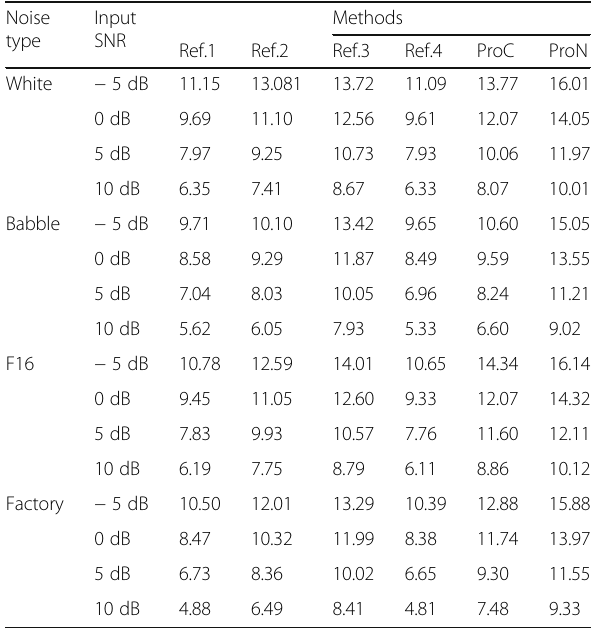
Table 2 Test results of SSNR improvement